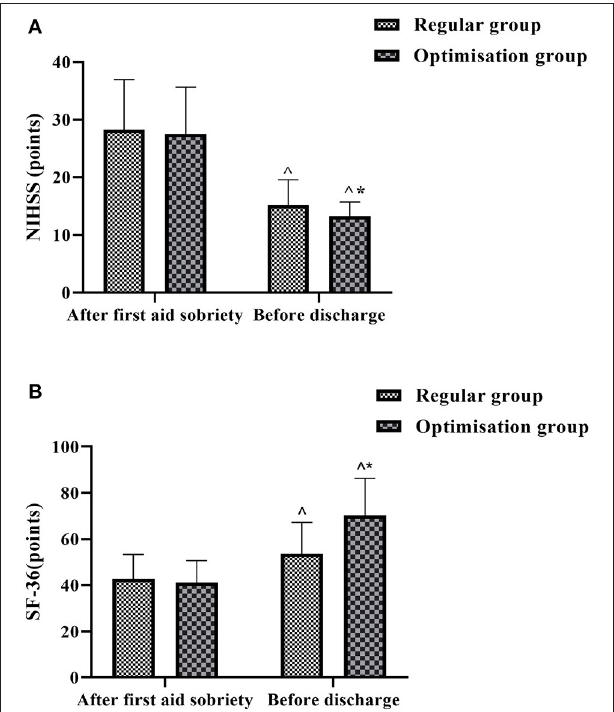
FIGURE 4 | Histogram comparing NIHSS scores and SF-36 scores between the two groups at different times. (A) Shows the comparison of NIHSS scores. (B) shows the comparison of SF-36 scores. ∧ Denotes comparison with the same group after first aid soberiety, P < 0.05. *Denotes comparison with the regular group, P < 0.05.